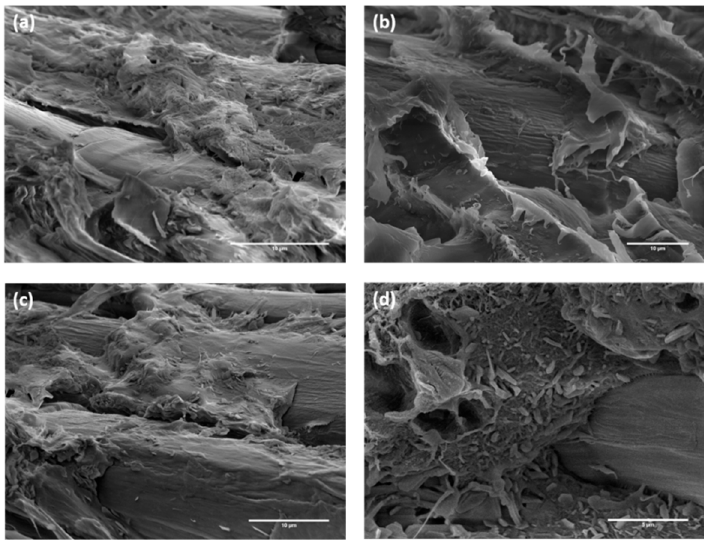
Figure 17. SEM micrographs of the fracture surfaces of PPC/Flax_SA composites at different magnifications.